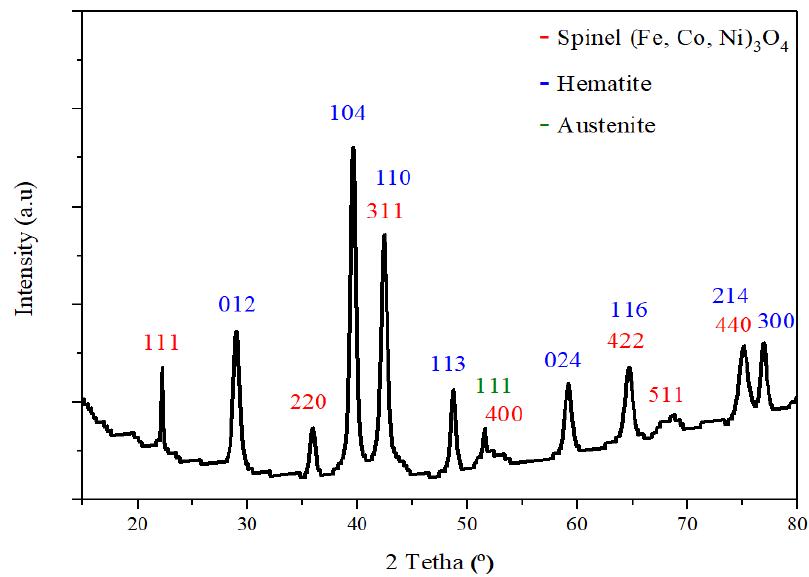
Figure 4. X-ray diffraction (XRD) spectra of the oxide layer formed on maraging 300 alloy. Peaks corresponding to γ -phase, Hematite and (Fe,Co,Ni) spinel are visible in the spectra.